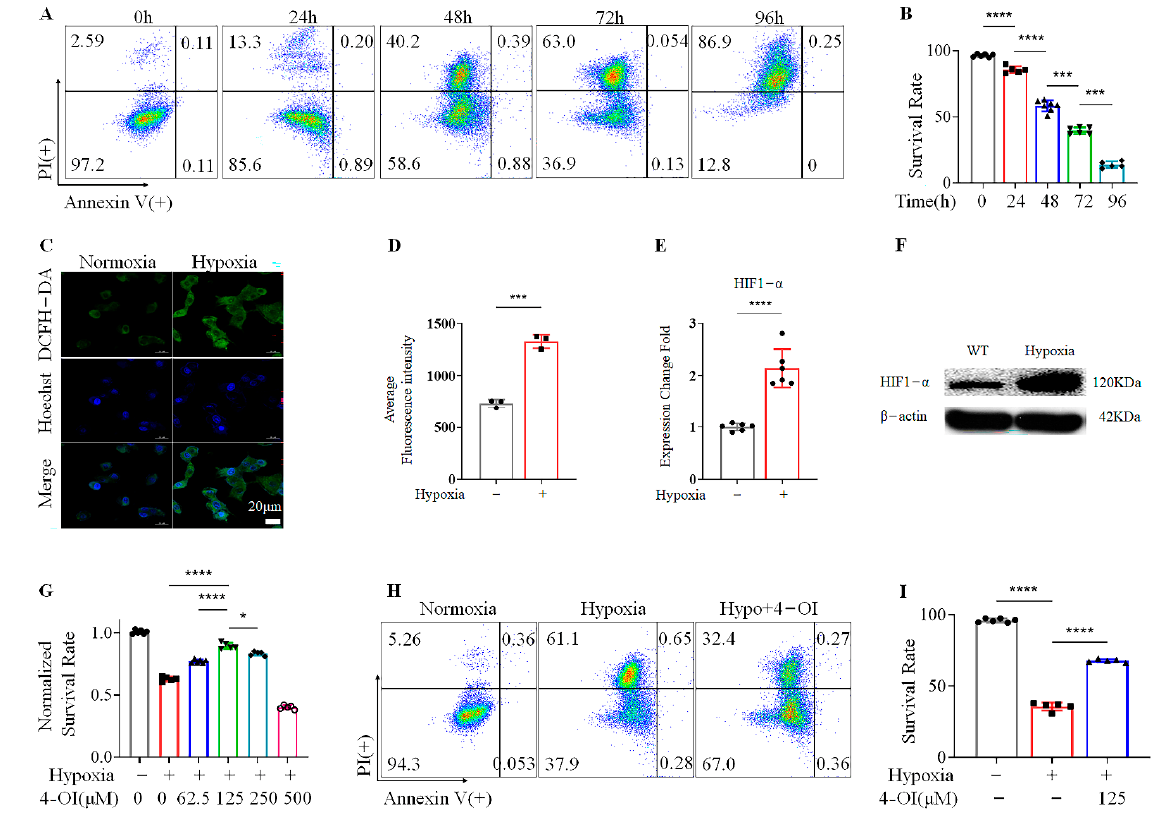
Figure 1. Treatment with 4-OI inhibits MIN6 cell death under hypoxic conditions: ( A , B ) FACS analysis showing MIN6 cell viability (stained with PI and Annexin V) under various durations of hypoxia ( A ), and its quantification ( B ). In FACS, the horizontal axis indicates positive Annexin V staining, and the vertical axis indicates positive PI staining. ( C , D ) ROS levels as assessed by confocal microscopy in MIN6 cells under hypoxia ( C ), and their quantification ( D ). ( E ) HIF1- α gene expression was assessed by quantitative real-time PCR in cells cultured under hypoxia for 72 h. ( F ) The expression of HIF1- α in MIN6 cells under hypoxia for 72 h was verified by Western blotting. ( G ) The effects of various concentrations of 4-OI on MIN6 cell viability when cultured under hypoxia for 72 h were measured by MTS. ( H , I ) FACS analysis showing the protective effect of 4-OI on MIN6 cells at 125 µ M concentration ( H ), and its quantification ( I ). Error bars represent the mean ± SD. An unpaired t -test ( D , E ) or one-way ANOVA ( B , G , I ) was performed with * p < 0.05, *** p <